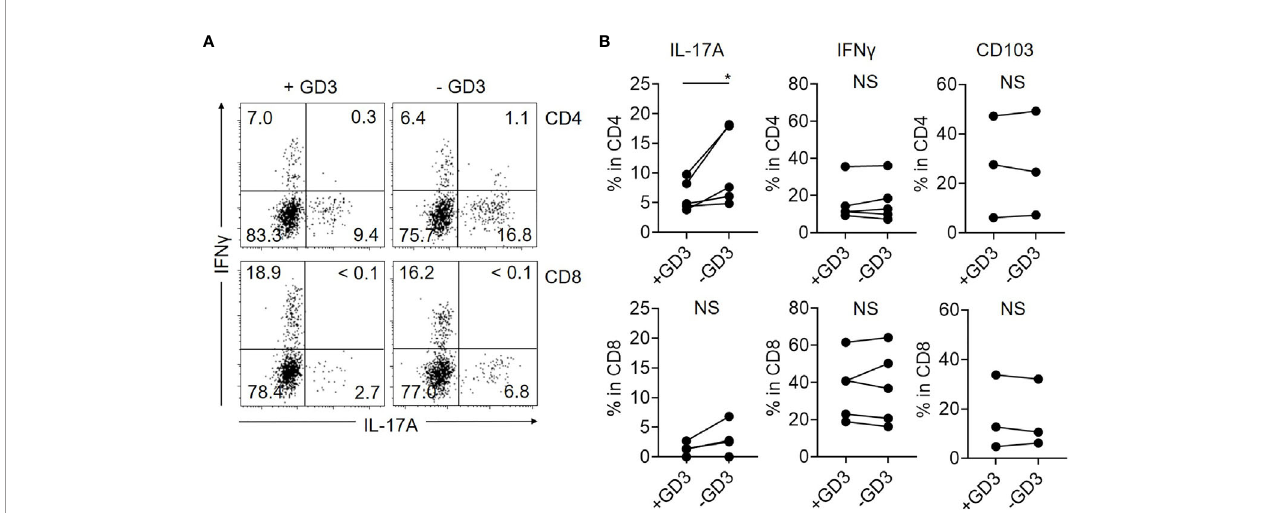
FIGURE 4 | GD3 suppresses the production of IL-17A by CD4 T cells. T cells from Ctl skin specimens were incubated with or without 10 µg/mL of GD3 and the cytokine production was assessed by fl ow cytometry. (A) Representative dot plots showing the production of IL-17A and IFN g from CD4 (top) and CD8 (bottom) fractions of Ctl skin specimens after incubation with (left) or without (right) GD3. (B) Graphs of the accumulated data showing the producing ratio of IL-17A (left) and IFN g (middle) in CD4 (top) and CD8 (bottom) fractions. N = 5. Right: Expression level of CD103 after incubating CD4 (top) and CD8 (bottom) T cells from Ctl skin specimens with or without GD3. N = 3. * p < 0.05. NS, not signi fi